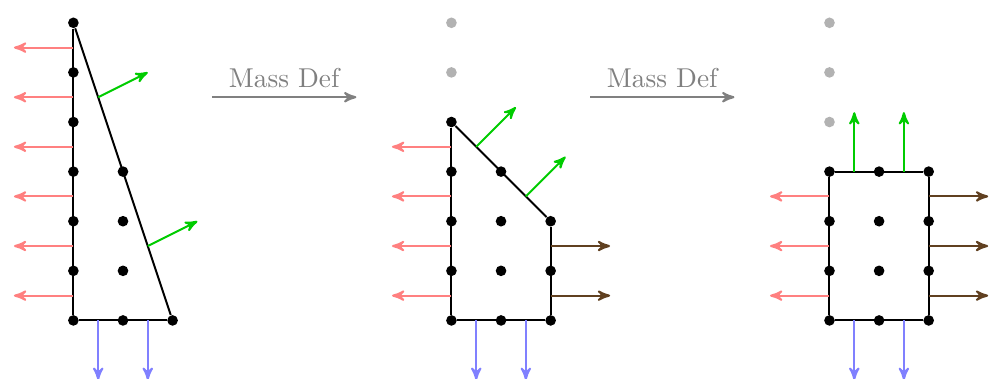
Figure 17. An example of a chain of toric diagrams of family A connected by mass deformation for k = 3 : L 0 , 6 , 0 / Z 2 → L 2 , 4 , 2 / Z 2 → L 3 , 3 , 3 / Z 2 . It holds also with the orientifold projection, mutatis